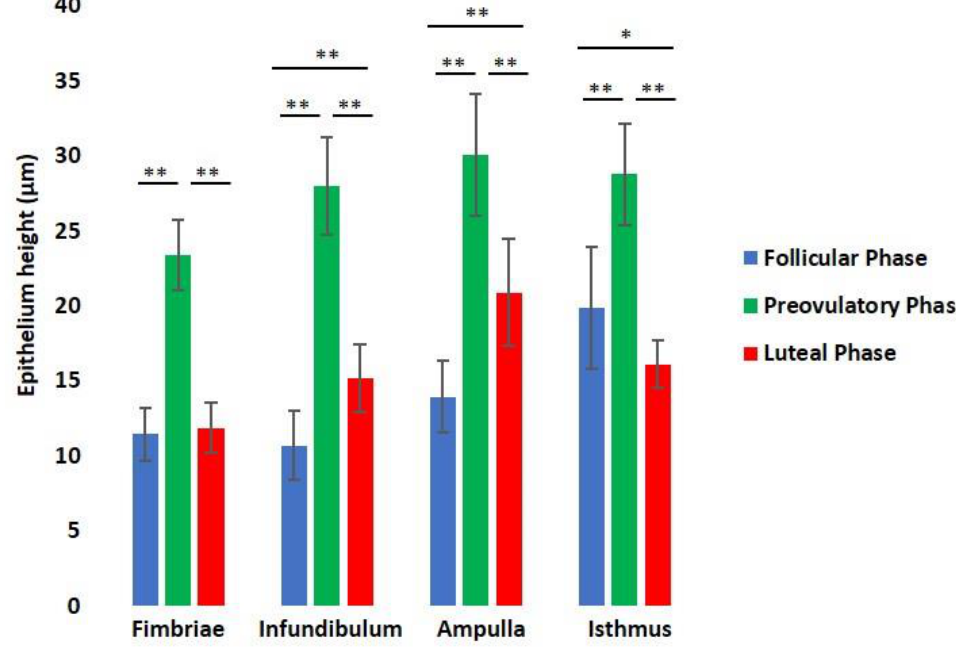
cycle. Values were expressed as means ± standard deviation (S.D.).